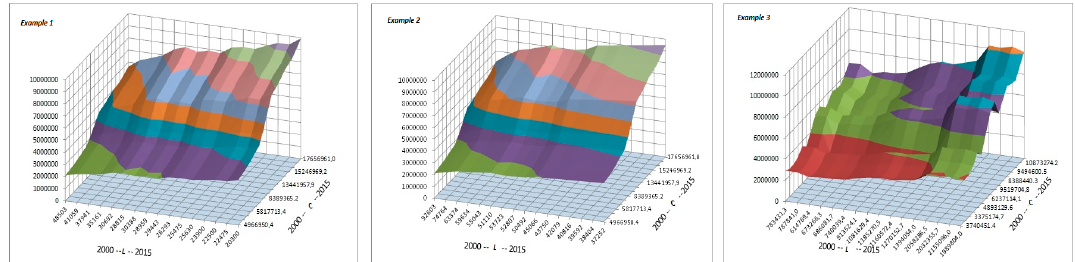
Figure 1. Graphical illustration of Cobb-Douglas production function models for Polish steel industry in restructuring period of 2000–2015 (in thous.). Source: own elaboration based on research results. Example 4 (dynamic model):